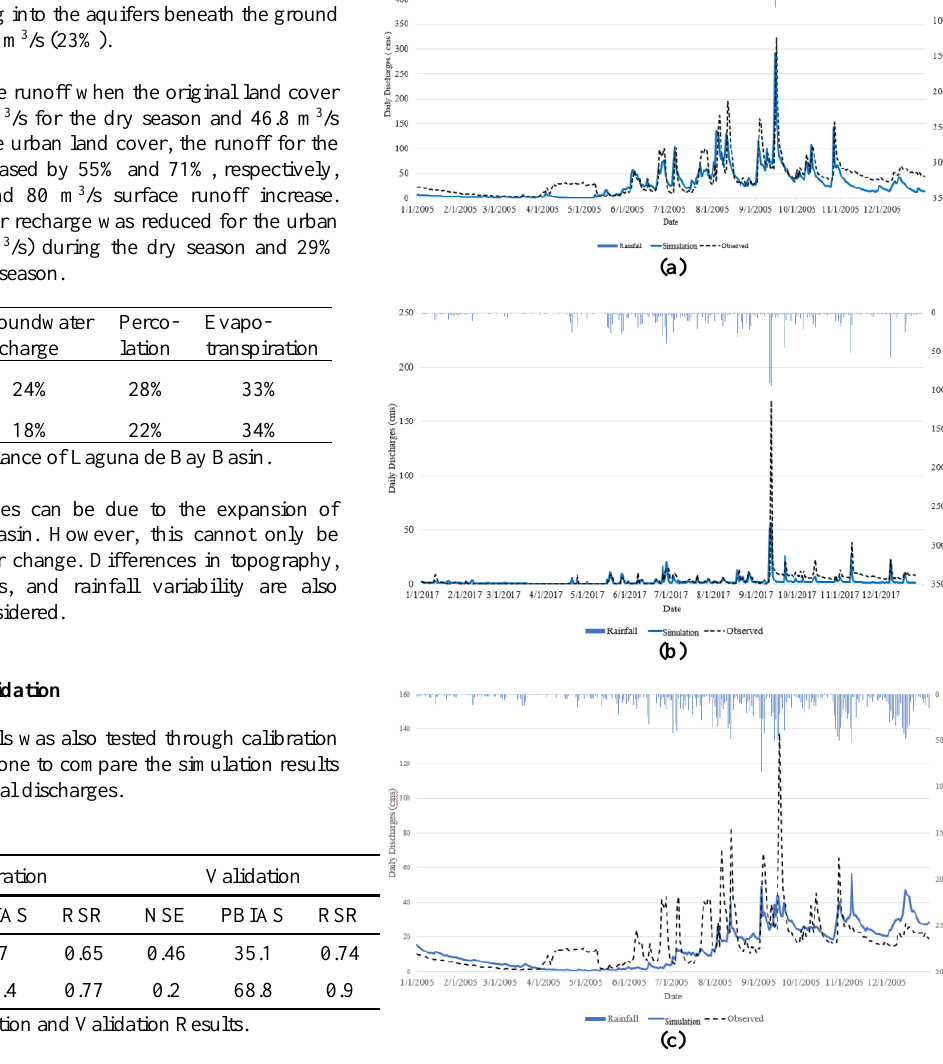
Figure 9 . Calibration plots for (a) Marikina subbasin, (b) Biñan subbasin, and (c) Sta. Maria